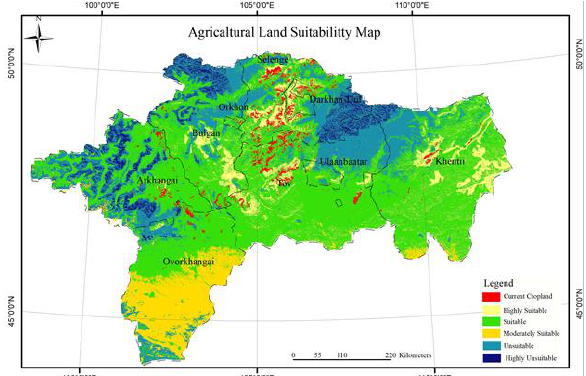
Figure 8. Spatial distribution of validation data polygons of current croplands overlapped on suitable cropland evaluation results in the central agricultural region of